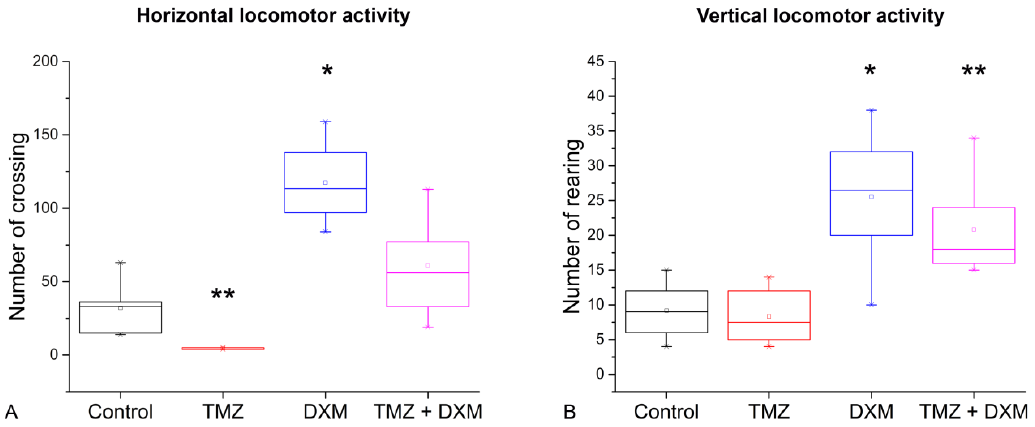
Figure 2. Locomotor activity of rats in the open field test after TMZ and/or DXM treatment. ( A ) Horizontal locomotor activity (number of square crossing). ( B ) Vertical locomotor activity (number of rearing). * p < 0.05, ** p < 0.01 compared with control. All data are expressed as mean ± SD